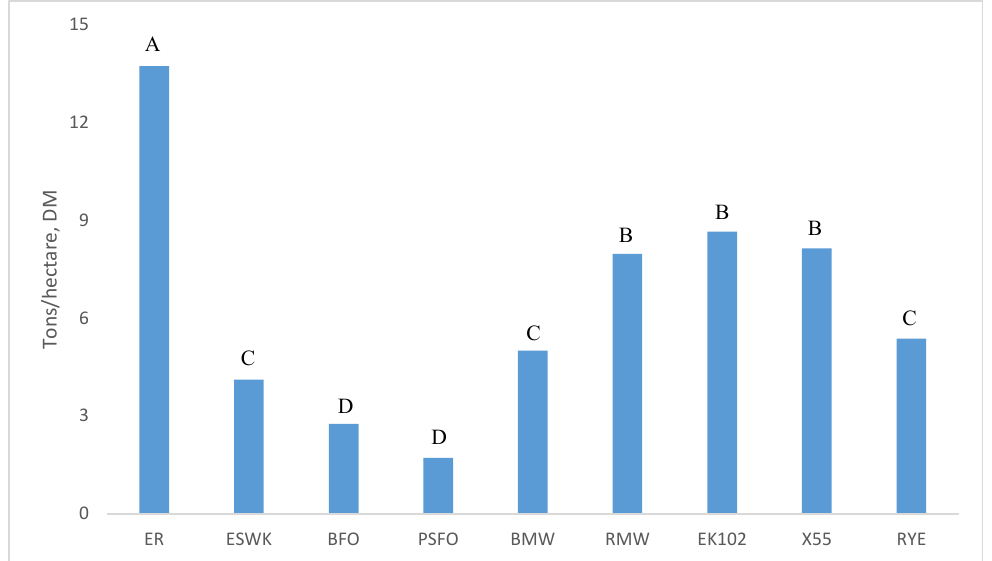
Figure 1. Forage plot yield of nine forage varieties ( P = 0.001). ER = Elbon Rye (cereal rye); ESWK = ES Winter Keeper (oat variety); BFO = Buck Forage Oats; PSFO = Plot Spike Forage Oats; BMW = Buck Master Wheat; RMW = Range Master Wheat; EK102 = EK 102 (wheat variety); X55 = X 55 Wheat; RYE = Rye Grass